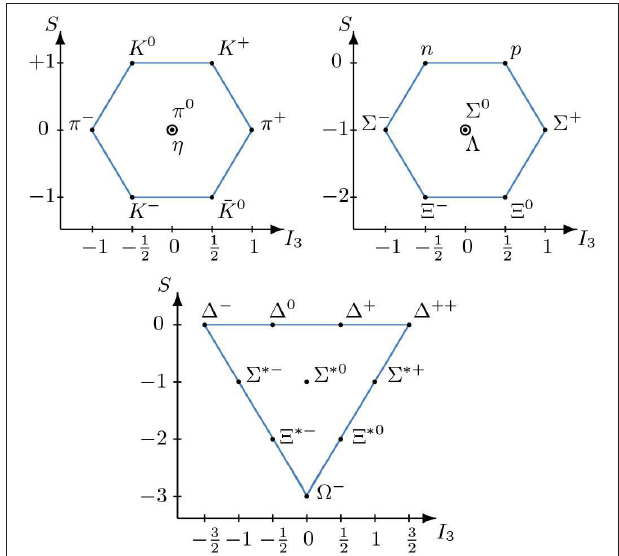
FIGURE 1 | Pseudoscalar meson octet ( J P and baryon decuplet ( J P